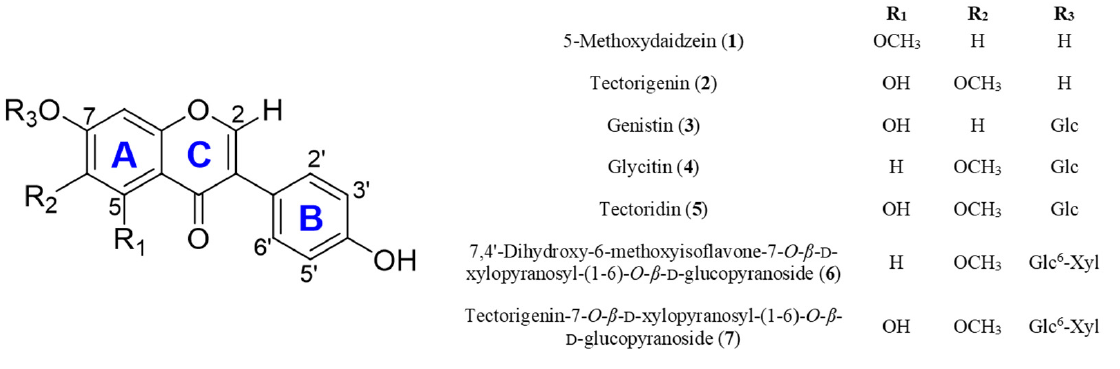
Figure 1. Chemical structures of isoflavones from Puerariae Flos.